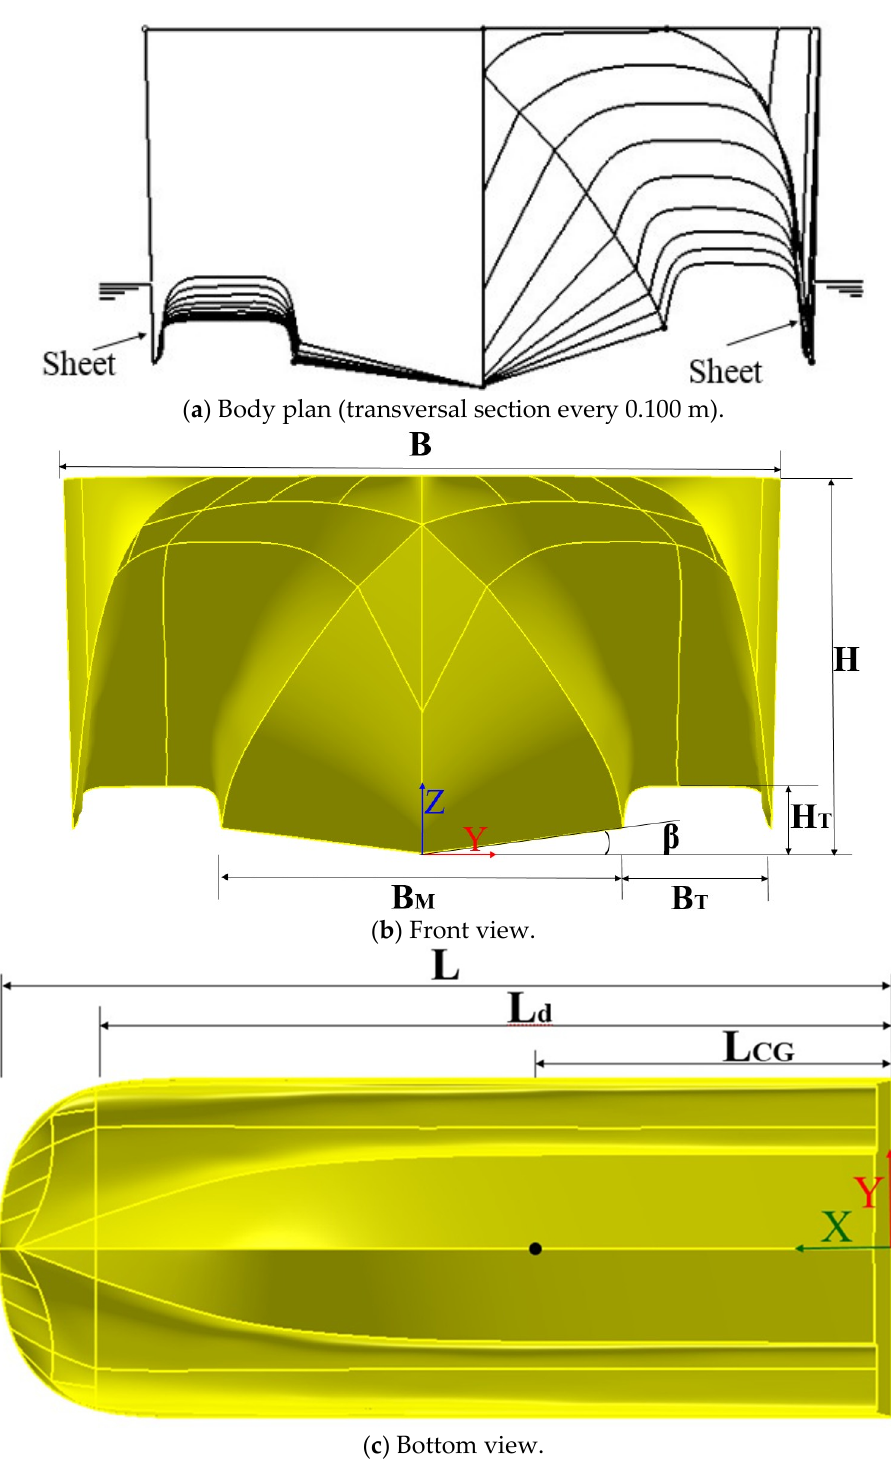
Figure 1. Specification of the planing trimaran.